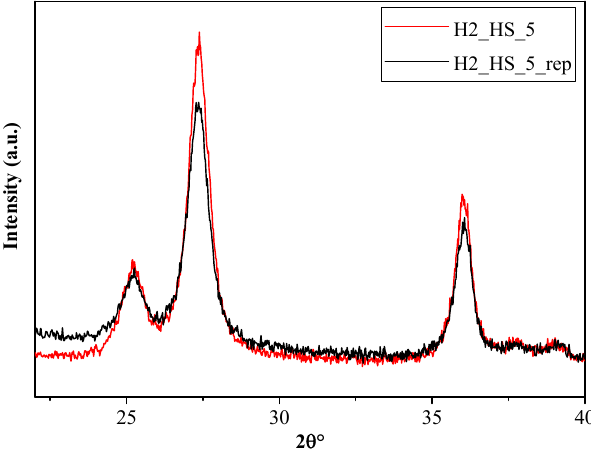
Figure 12. XRD diffractograms of H2_HS_5 before and after the 3 consecutive phenol degradation tests (H2_HS_5_rep).